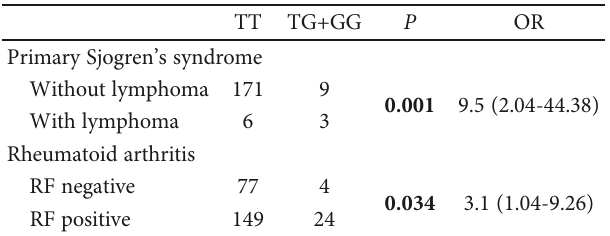
Table 2: Association between disease phenotypes and rs2230926 (T > G)